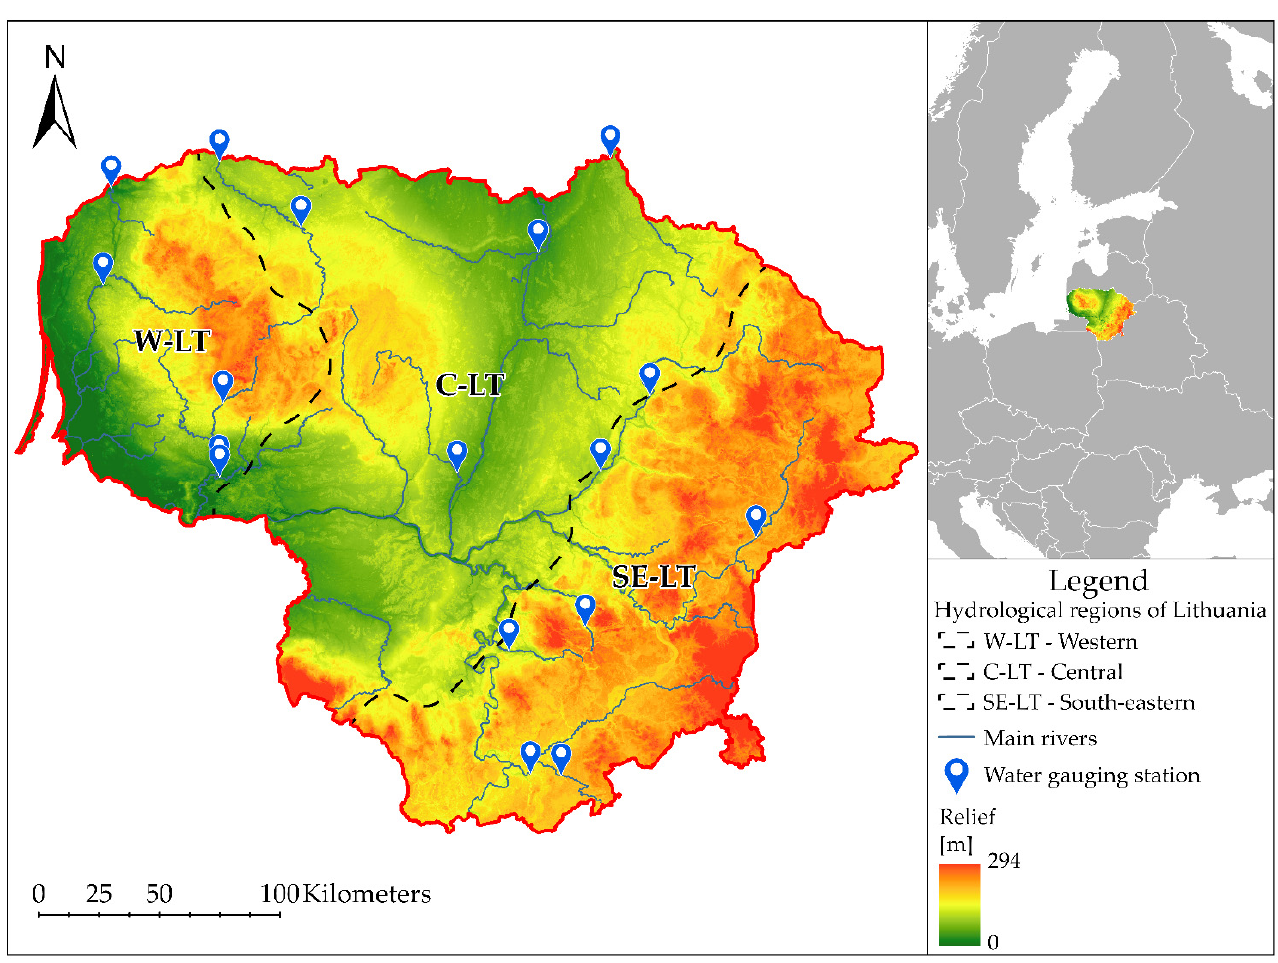
Figure 1. Geographical position ( left ) and water gauging stations of three hydrological regions of Lithuania ( right ). Table 1. Characteristics of selected water gauging stations (1961–2020).